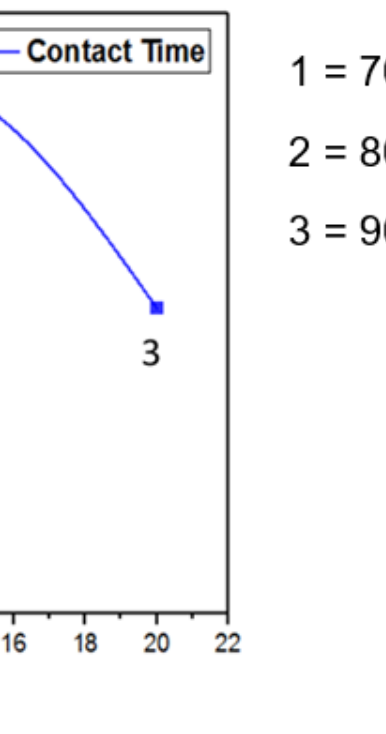
Figure 7. Effect of optimized contact time on carbon yield.